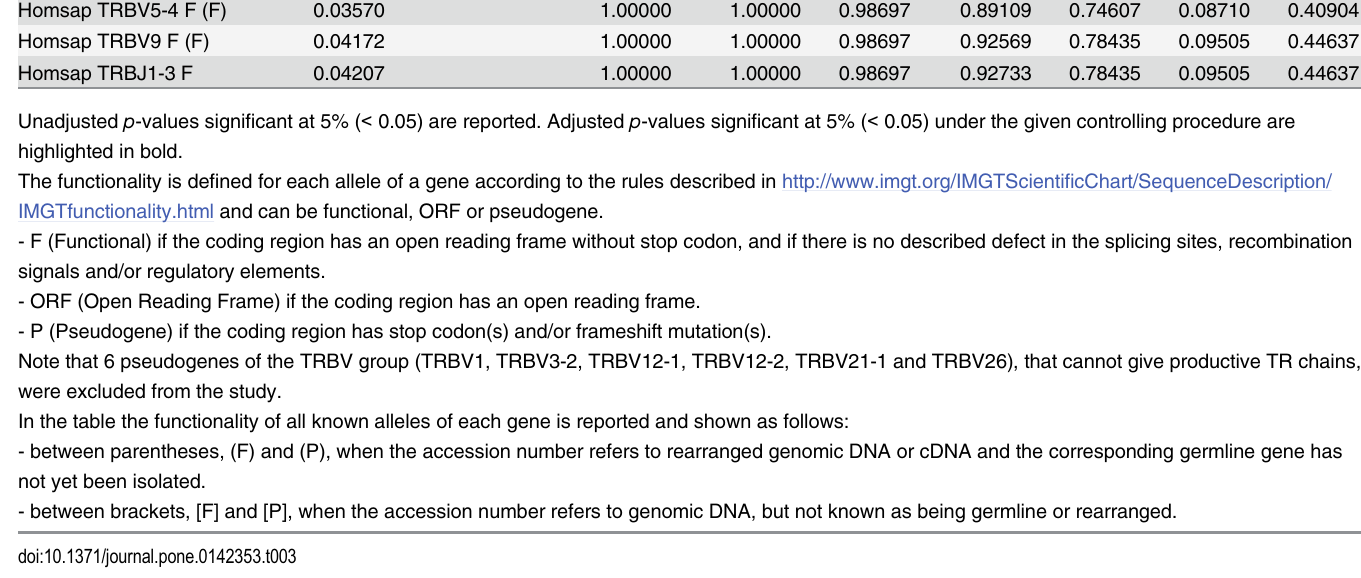
In order to visualize the statistical analysis results obtained using the multiple testing proce- dures, two types of plots (line graphs and scatter plots, Fig 2) were generated for each compari- son using the Bioconductor (http://www.bioconductor.org) R package multtest [38]. The line graphs (Fig 2, left panel) represent the number of rejected hypotheses (number of significant values in Table 3) against the Type I error rate ( α -level). Dotted lines represent unadjusted p -values (rawp) whereas colored lines represent ajusted p -values of the seven proce- dures. These graphs allow to visualize the number of rejected null hypotheses for a chosen α - level under a given procedure. Thus, by fixing the smallest adjusted p -values obtained by the procedures at a Type I error rate ( α -level = 0.05) (vertical line in Fig 2), the numbers of rejected null hypotheses (numbers of adjusted p -values in bold in Table 3), for example with the BH procedure (red line), are 10 (Pre), 16 (d3), 13 (d8) and 21 (d26), whereas with the Bonferroni procedure (purple line), they are 6 (Pre), 10 (d3), 8 (d8) and 15 (d26). The line graphs also allow to identify, for a selected number of rejected null hypotheses, the α -level which is required to get that number for a given procedure. ) of unad- The scatter plots (Fig 2, right panel) display negative decimal logarithms (-log 10 justed p -values (black symbols) and adjusted p -values obtained by each multiple testing proce- dure (colored symbols) against the test statistics z -scores on abscissa (values in S2 Table). As the p -values range from 0 to 1, their negative decimal logarithms are used in the plots to (horizontal line in Fig 2). Therefore, significant differences in proportions of IMGT clonotypes (AA) with a gene k at a Type I error rate α -level = 0.05 for the different procedures correspond ( p -value) > 1.3 and with a z -score less than -1.96 ( < to those represented with a -log 10